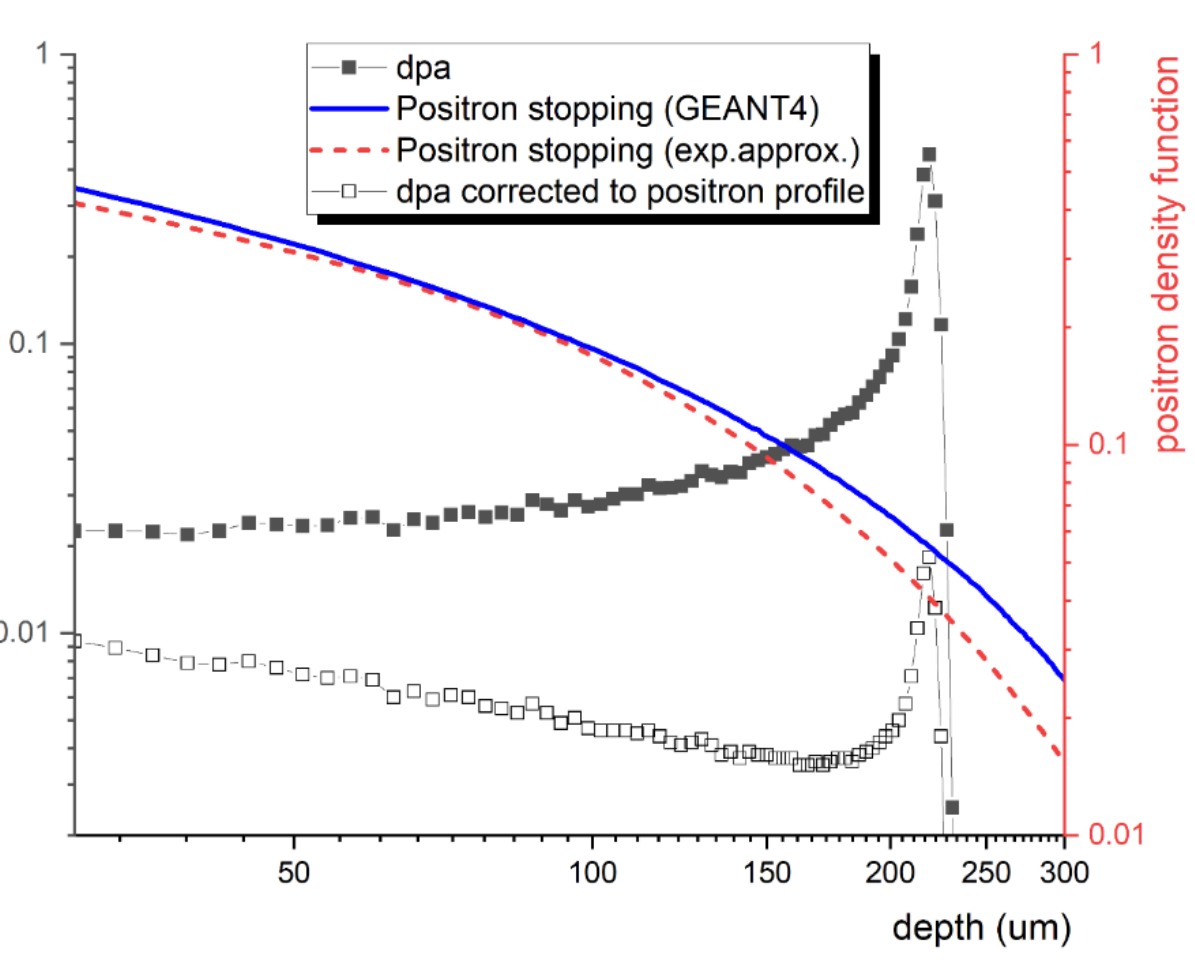
Figure 3. SRIM-based calculation for the dpa with 5 MeV protons.